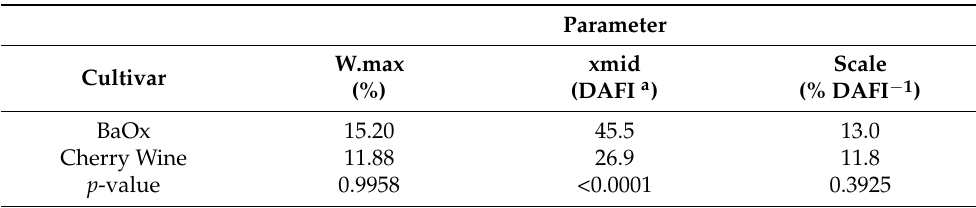
Table 5. Parameter estimates of the logistic model for floral hemp total CBD concentration over time for the floral hemp cultivars BaOx and Cherry